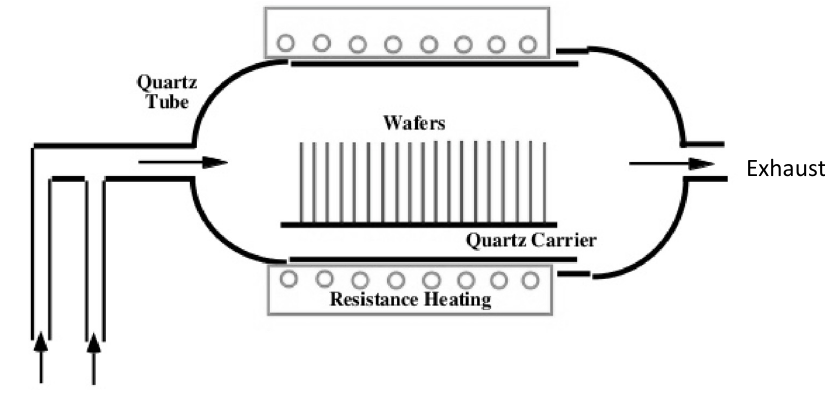
Figure A1. An oxidation system.